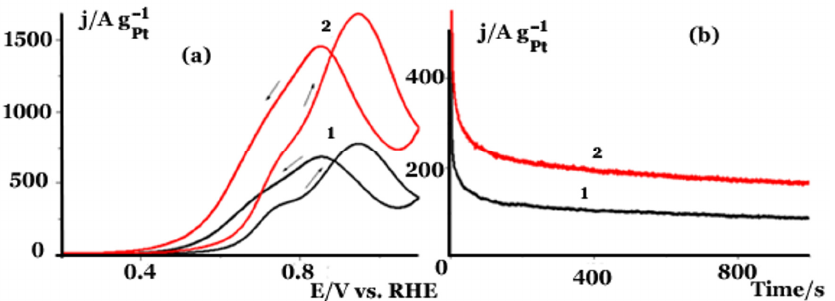
Figure 6. ( a ) Cyclic voltammograms of ethanol oxidation at the commercial Pt/C (1) and the pre- pared PtMoSn/C (2) catalysts recorded in 0.5 M H 2 SO 4 + 1 M ethanol electrolyte at 0.005 V s − 1 scan rate; ( b ) the corresponding chronoamperometric curves recorded at 0.6 V.